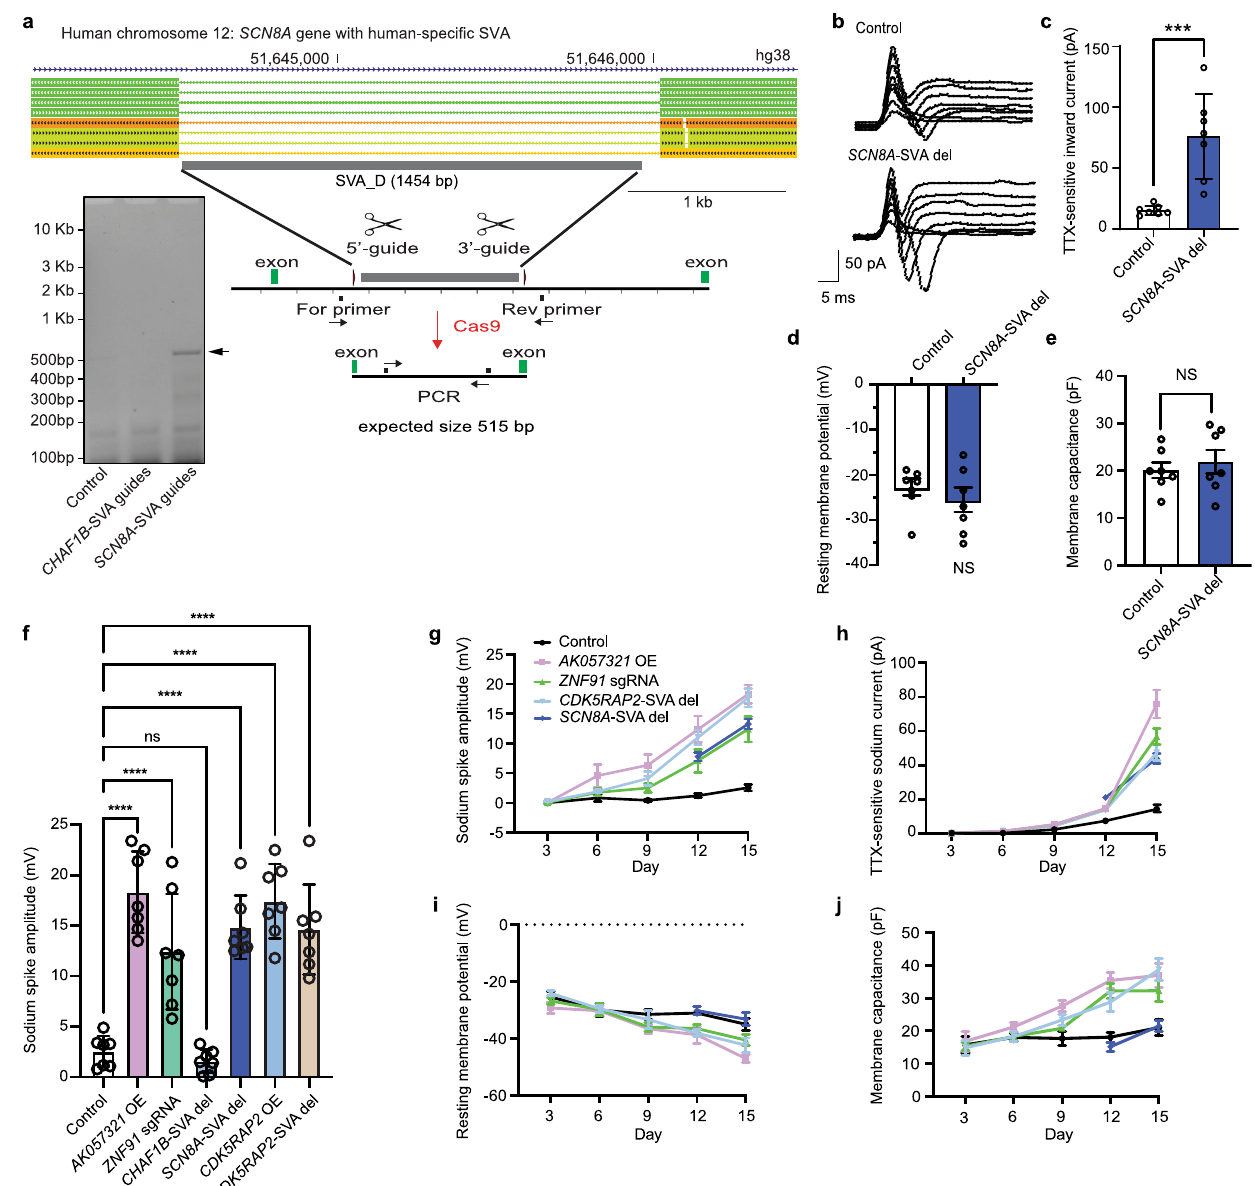
Fig. 4 A human-speci fi c SVA-D in SCN8A delays maturational increases of voltage-gated sodium current. a Schematic showing SVA_D located within the SCN8A gene is a human-speci fi c insertion (UCSC genome browser, GRCh38/gh38) and strategy for Crispr/Cas9 SVA_D deletion strategy with DNA agarose gel image showing expected SVA-deletion PCR product size of 515 bp present only with transfection of SCN8A guides which were used for all subsequent experiments. b Representative sodium current traces in SCN8A-SVA del group in response to step depolarization were shown. c TTX-sensitive current in SCN8A -SVA del group ( n = 7) is higher than in control ( n = 7). Unpaired Student ’ s t test. *** p < 0.001. d Resting membrane potential (RMP) in SCN8A -SVA del ( n = 7) and control ( n = 7) group has no signi fi cant difference. Unpaired Student ’ s t test. e , Capacitance in SCN8A -SVA del ( n = 7) and control ( n = 7) group has no signi fi cant difference. Unpaired Student ’ s t test. Whole-cell patch-clamp recording of NTera-2 cell up to day 15 in culture in different treatment groups: f Current injection (300 pA) at day 15. g Change in voltage (Delta V). h TTX-sensitive inward currents. i Resting membrane potential. j Cell membrane capacitance. Two-way ANOVA with Bonferroni post hoc tests. Data represent the mean ± SEM. **** p < 0.0001, *** p < 0.001, ns p >